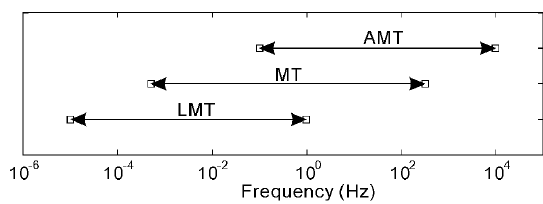
Figure 1. Three MT sounding methods with different frequency ranges. Table 1. PRBS parameters for three MT